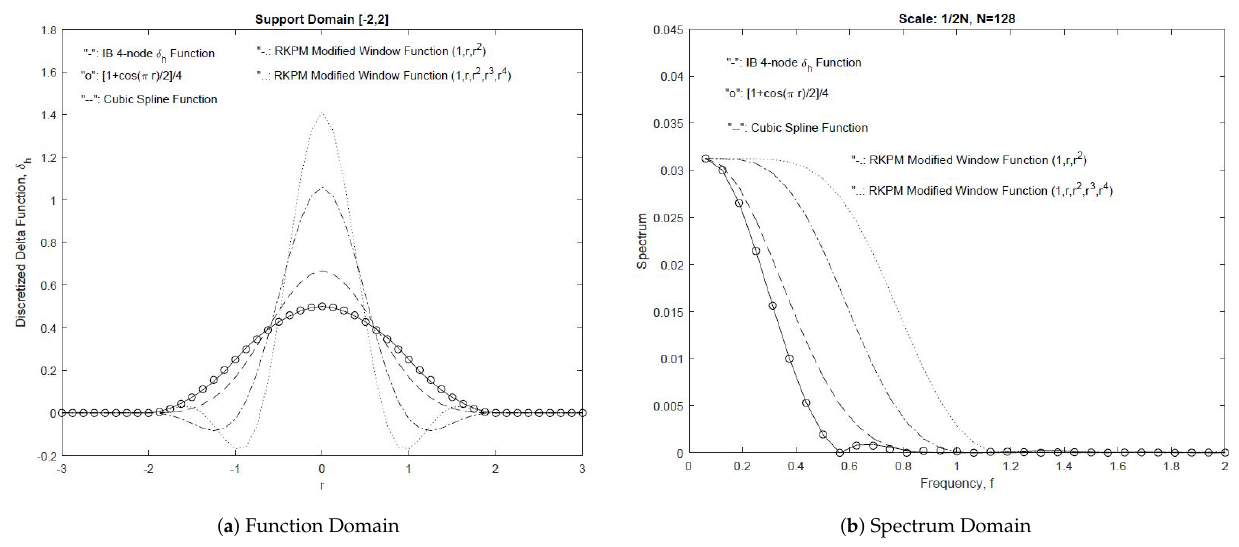
Figure 4. A comparison of various discretized delta functions and their spectra (from the author’s earlier work